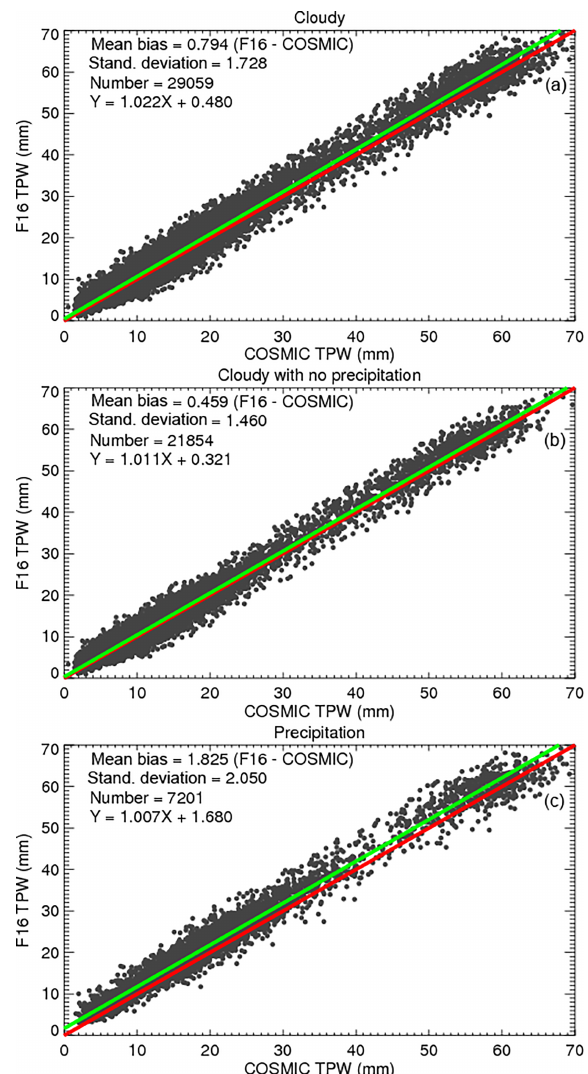
Figure 3. TPW scatter plots for the COSMIC and RSS version 7.0 F16 SSM/I pairs under (a) cloudy, (b) cloudy but non-precipitating, and (c) precipitating